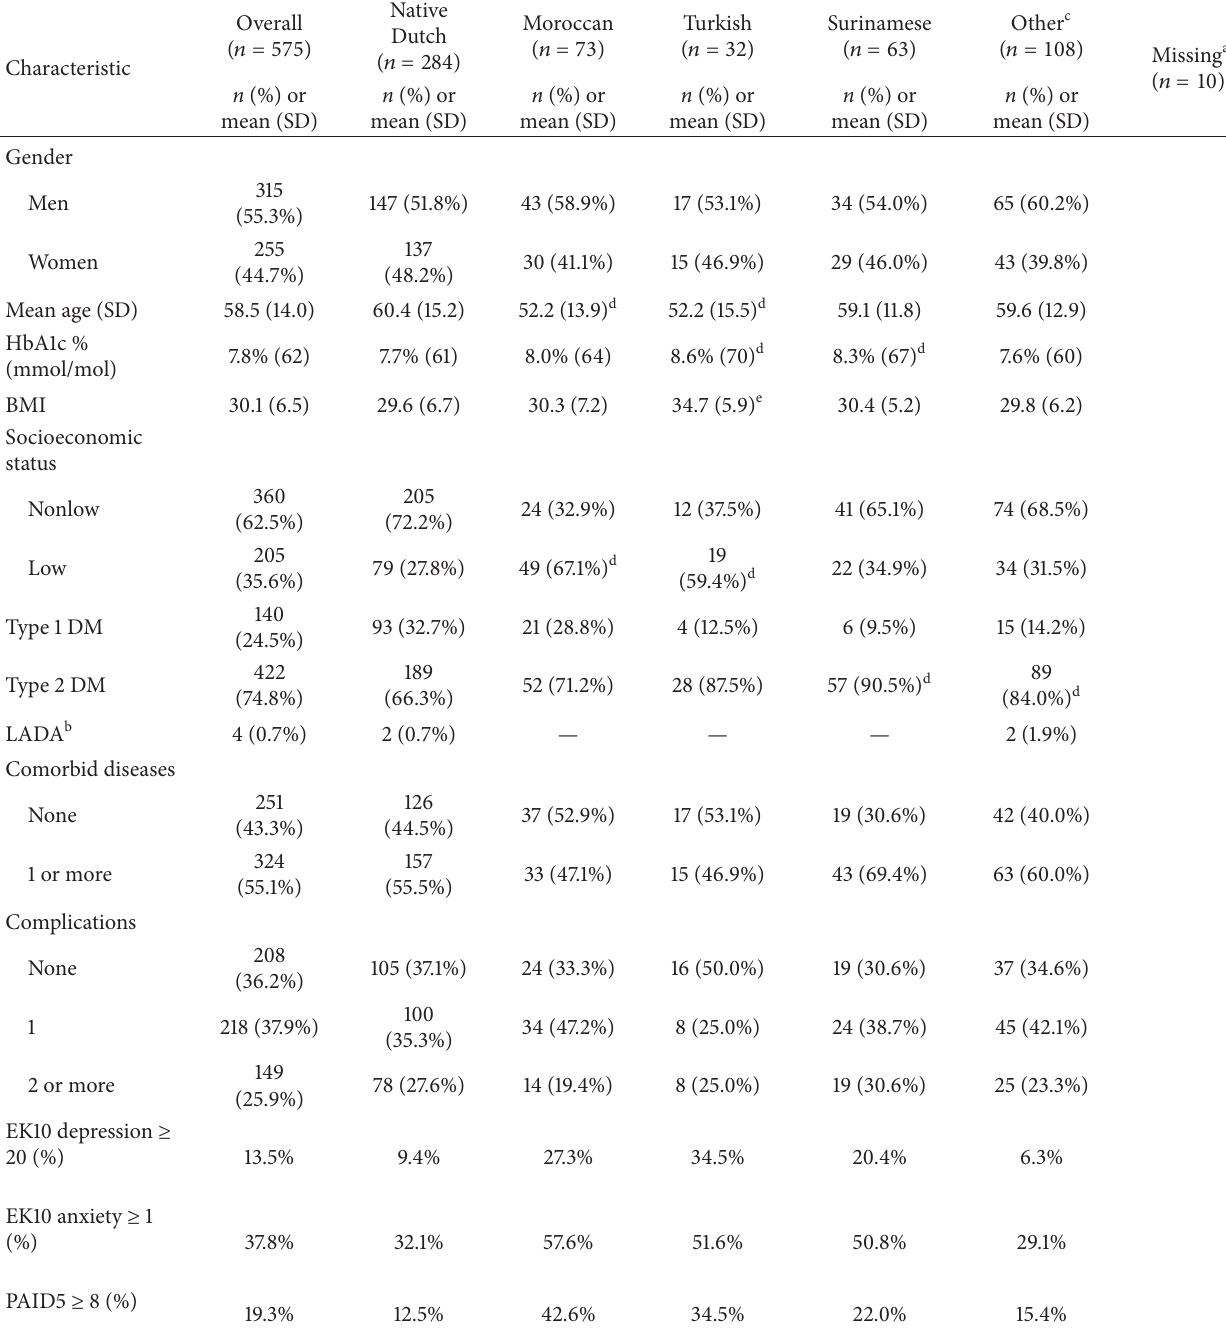
Table 2: Demographic characteristics and prevalence rates of high EK10- and PAID5-scores of respondents divided by ethnicity ( 𝑛 = 575 ).